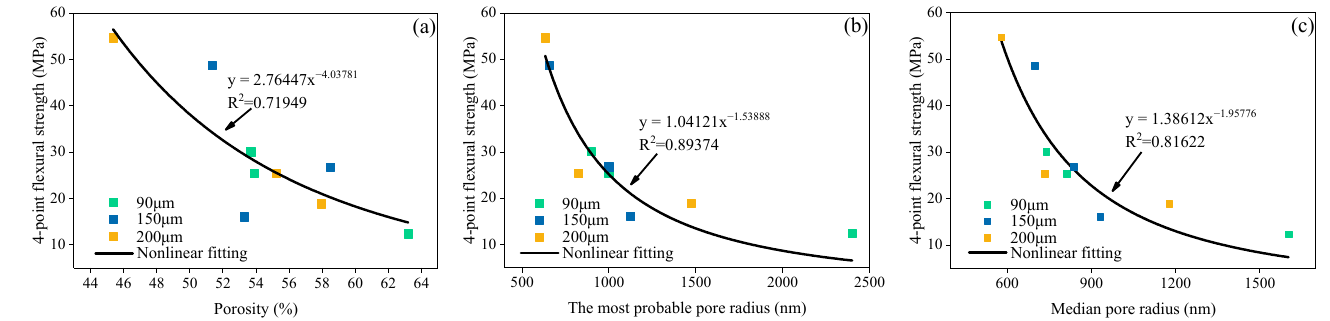
Figure 11. Relationship between flexural strength and ( a ) porosity, ( b ) the most probable pore size, and ( c ) median pore radius of porous alumina samples with 70 vol.% pore-forming agents.